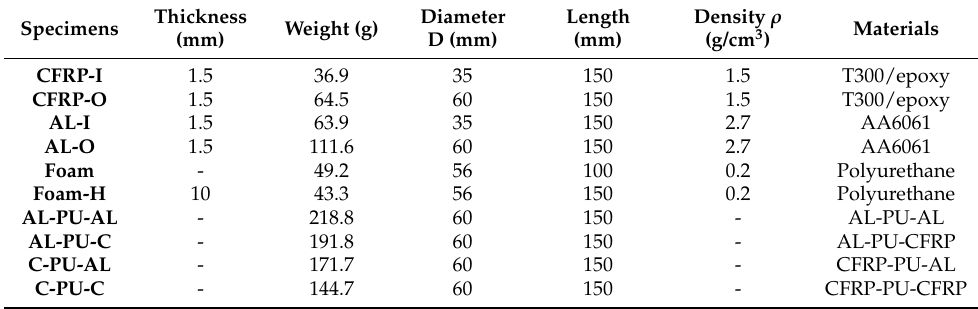
Table 1. Summary of all the specimen for the experimental study.